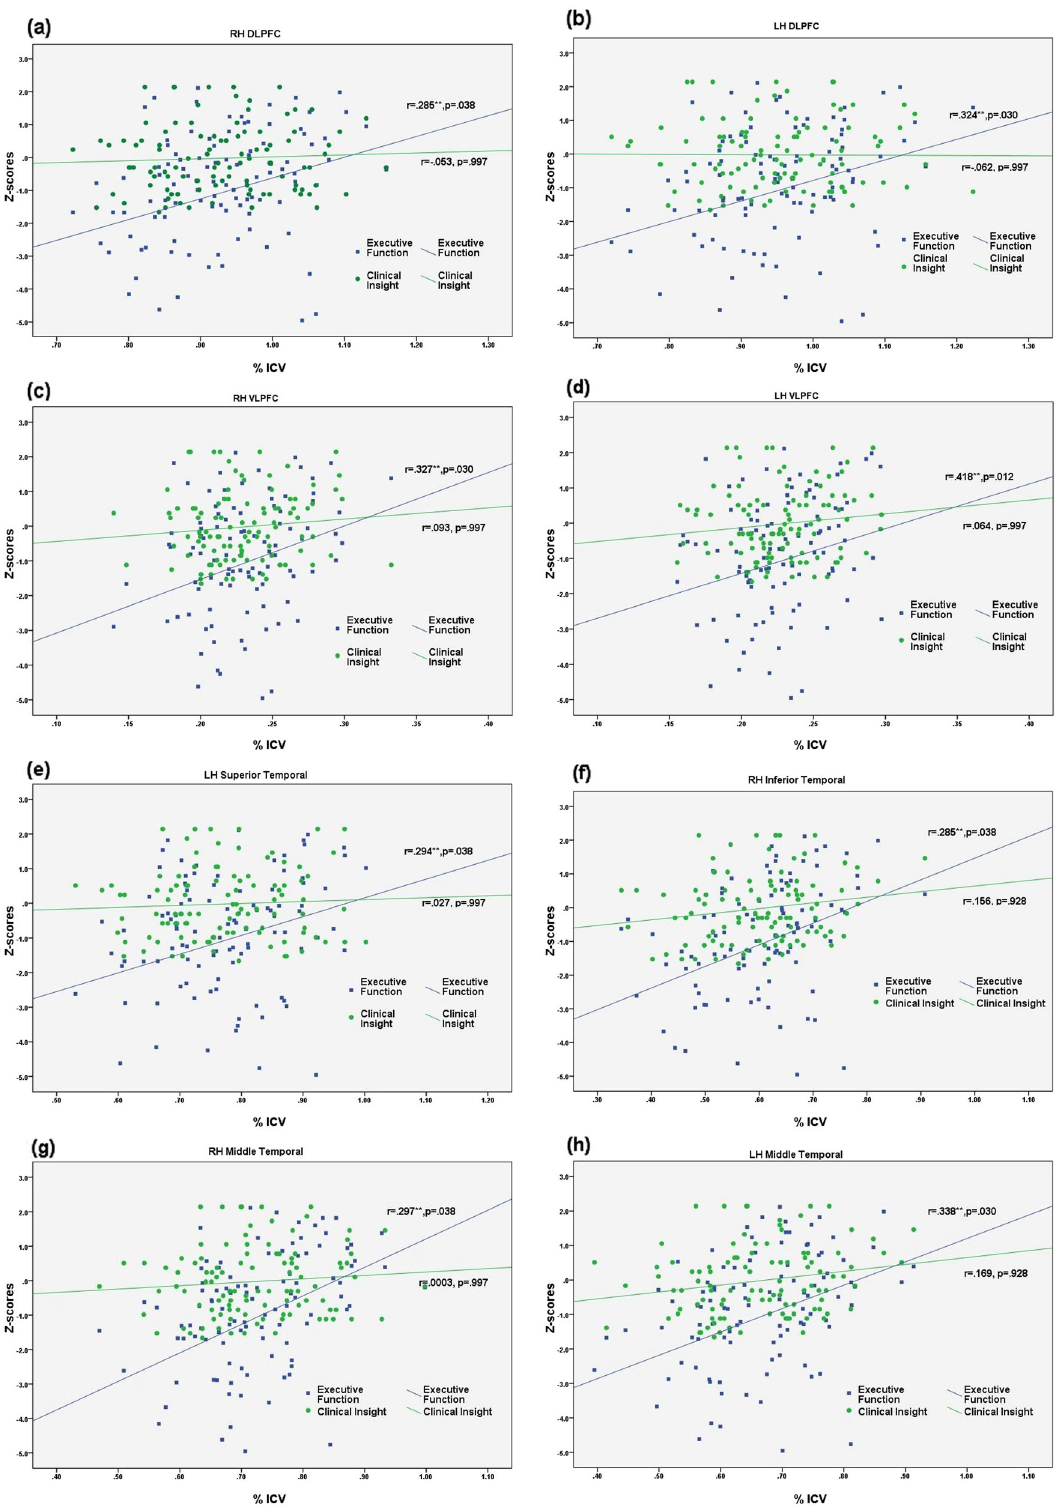
Fig. 3 Correlations between ICV-adjusted volumes and cognitive performance and clinical insight. Scatter plots demonstrating signi fi cant positive relationships between cognitive domains and ICV-adjusted volumes, adjusted for duration of illness, medication and education in SZH. Executive function scores positively correlated with volume in bilateral DLPFC ( a . right: p = 0.038, left: b . p = 0.030), bilateral VLPFC ( c . right: p = 0.030 and d . left: p = 0.012), left superior temporal ( e . p = 0.038), right inferior temporal ( f . p = 0.038), and bilateral middle temporal (right: g . p = 0.038 and left: h . p = 0.030). **FDR corrected p <